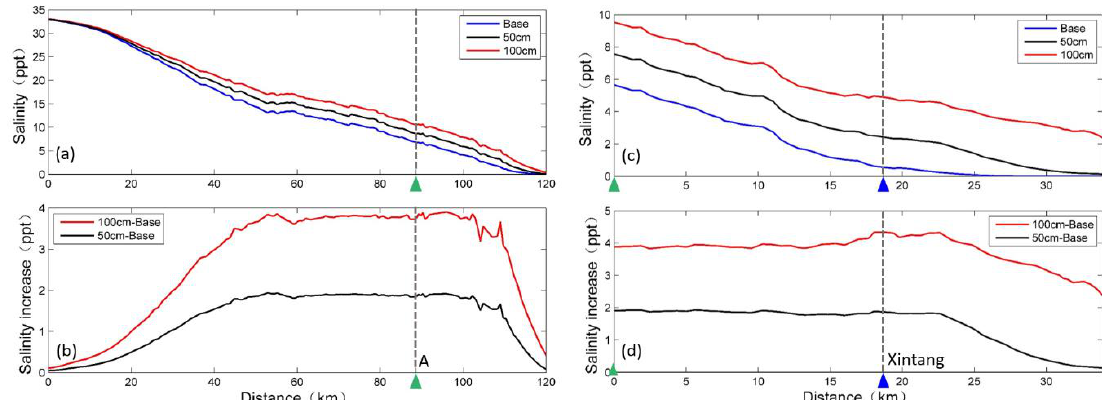
Figure 4. ( a ) Mean salinity along the transect in the main channel of the PRE (see Figure 1a for the location) for the base case and each sea-level rise case; ( b ) the increase in the mean salinity along the transect in the main channel of the PRE in each Scheme 1. c for the location); ( d ) same as ( b ) but for the transect along the tributary where Xintang is located. The results are average values from January 2008. The triangles indicate the location of station A ( a , b ) and Xintang ( c , d ) in each panel.